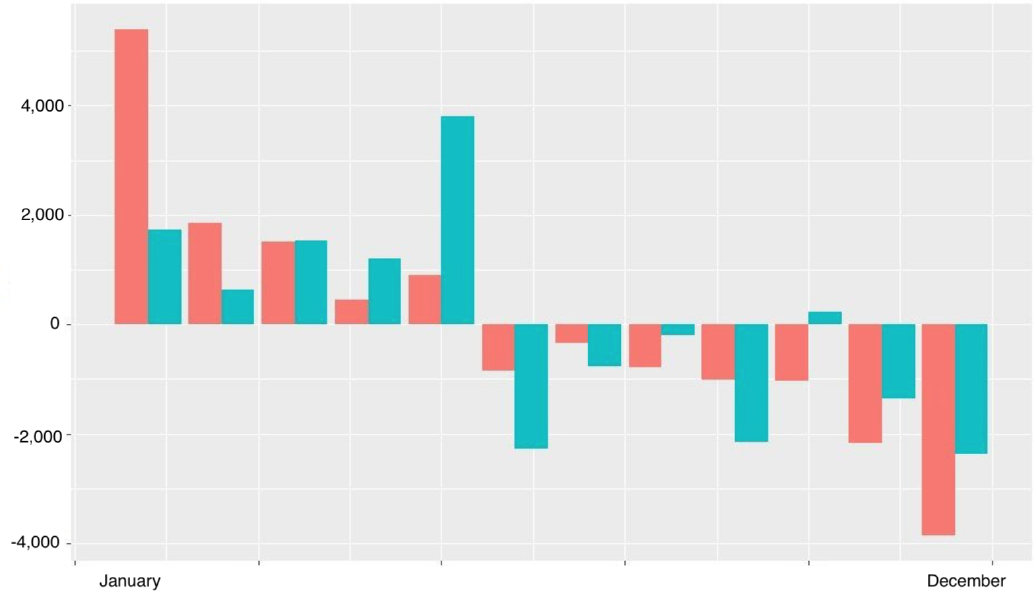
Figure 11. Variation of the average of quotes per month and the closing value in 2018. Red: Price and Green: